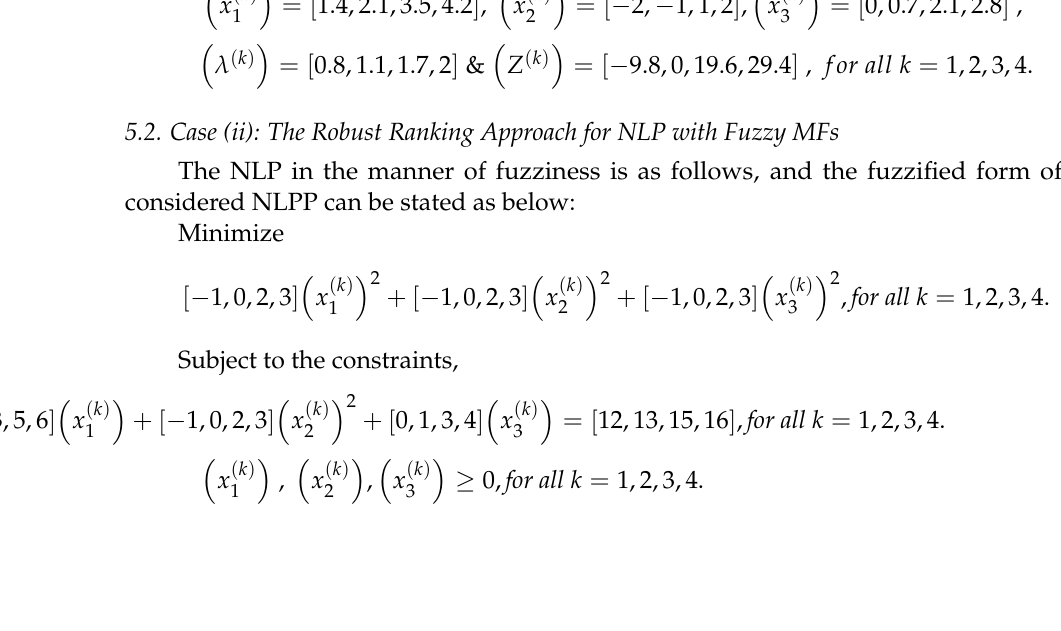
(cid:16) (cid:17) ( k ) = [ 0, 0.7, 2.1, 2.8 ] , x 3